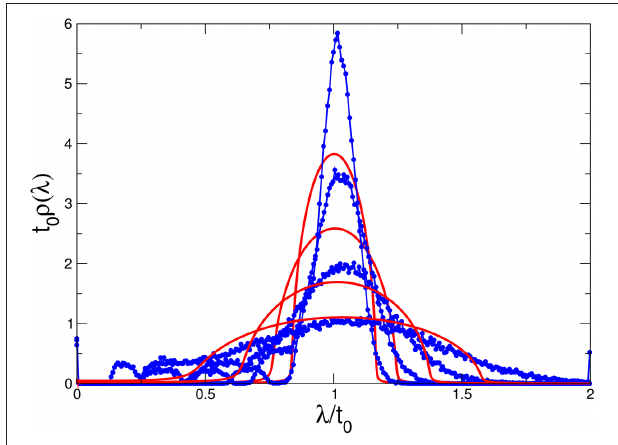
FIGURE 2 | Comparison between the numerically calculated level density ( N 200, blue connected symbols) with the results of ERM-SCBA (red lines) = for Ŵ 0.3, 0.65, 1.5, and 3.5 (from top to =